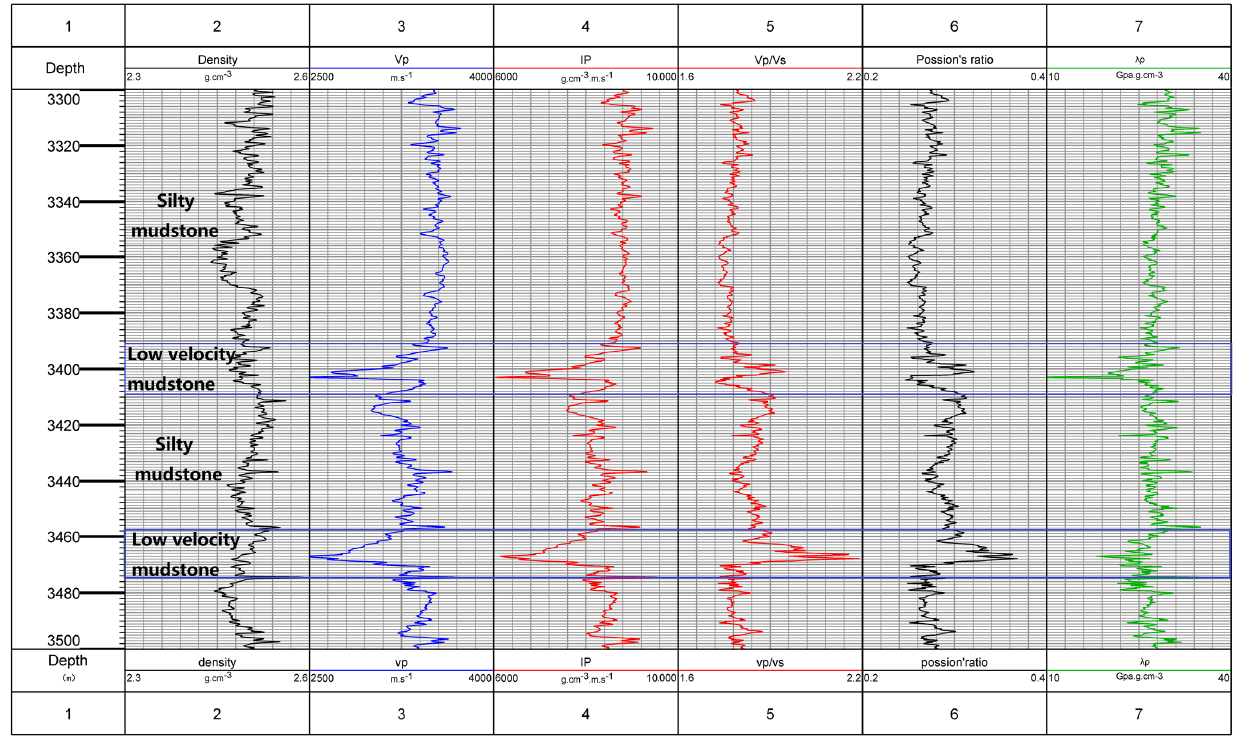
Figure 13. Logging curve of well DF1-X6.